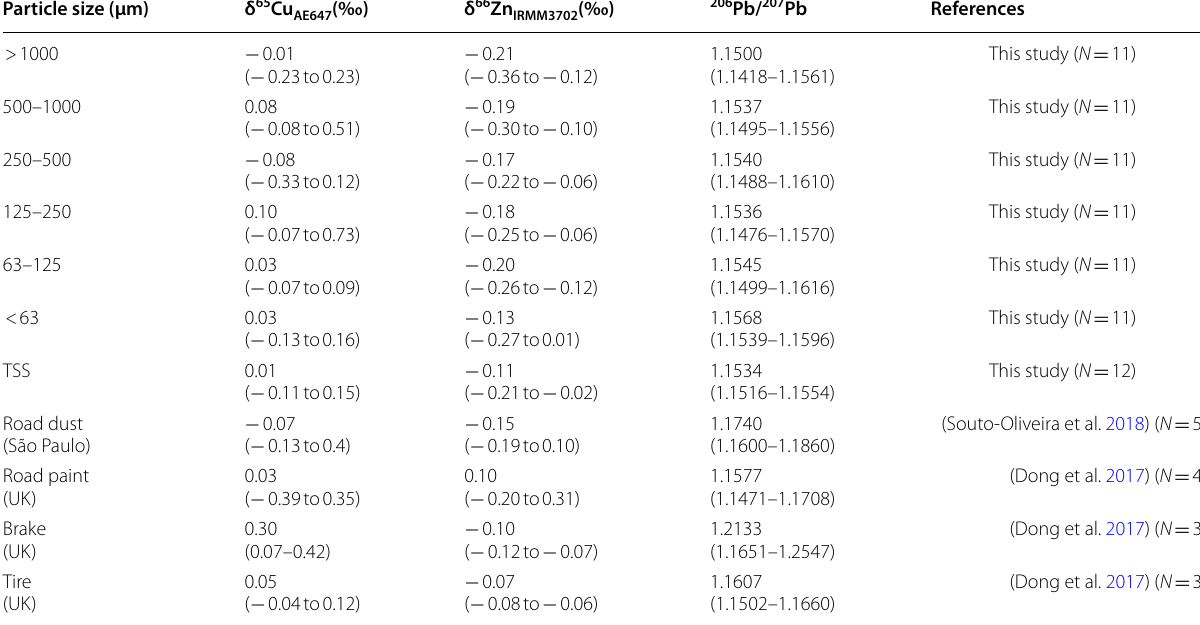
Table 2 Comparison of mean, minimum, and maximum values for Cu, Zn, and Pb isotopic composition of this study and other reported literature